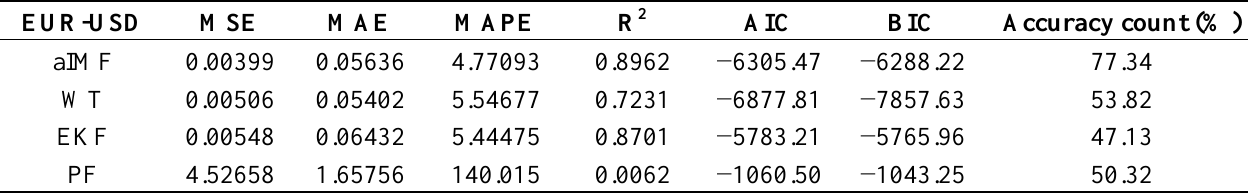
Table 1. Performance measurements of original datasets using noise distribution at 100% with 1 Hz and 10% amplitude of the original signals.